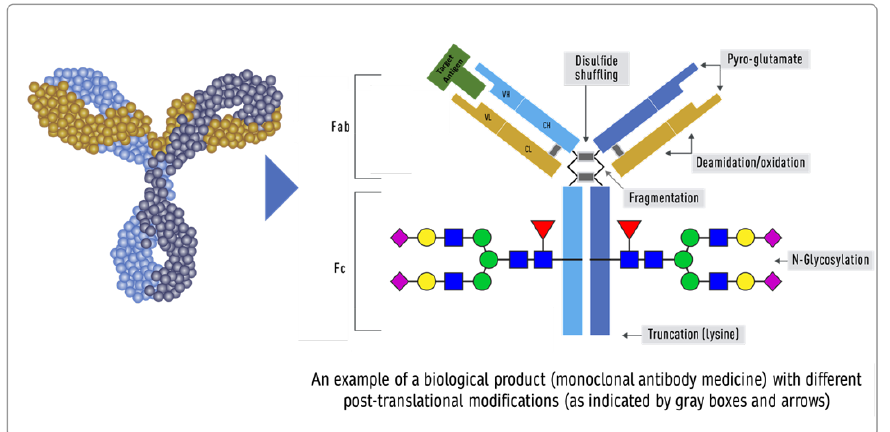
Figure 3. Inherent variations in biological products (FDA: https://www.fda.gov/drugs/biosimilars/curriculum-materials-health-care-degree-programs-biosimilars; accessed on 4 April 2022) [40].